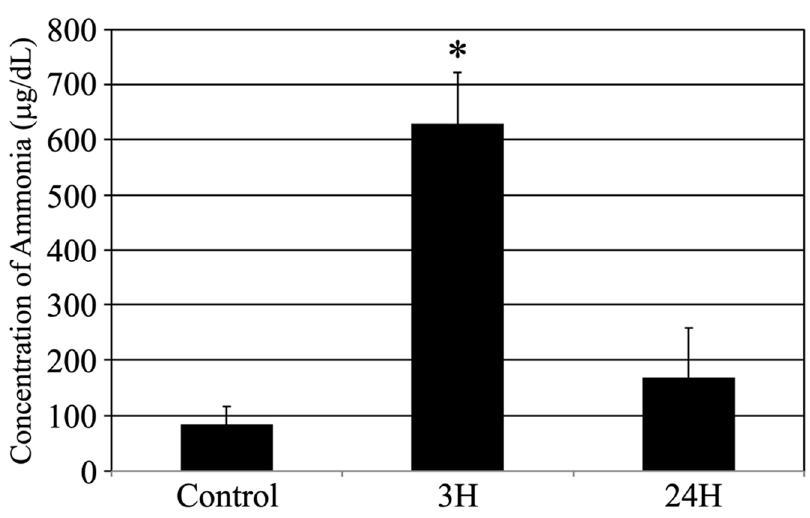
Figure 1. Control, 3H, and 24H indicate the average blood ammonia concentration for the animals in the vehicle treatment control group and the treated animal at 3 and 24 h after ammonia treatment, respectively. Data are expressed as the mean ± standard error. *: p < 0.05 compared with the control value.